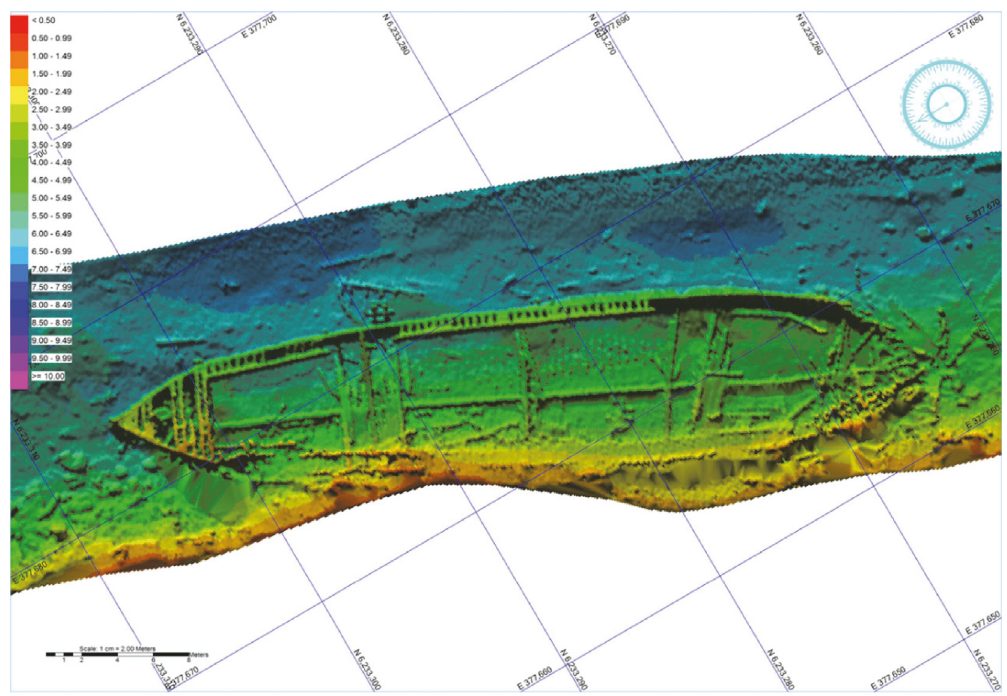
Figure 2: Multibeam image of the Crowie barge (courtesy image of Gareth Carpenter, previously published in [13]: 141).